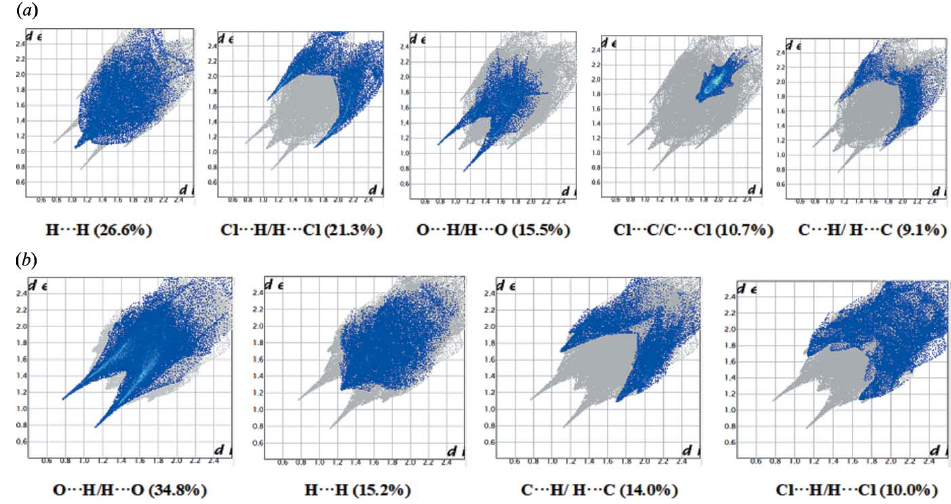
Figure 7 Two-dimensional fingerprint plots for ( a ) (I) and ( b ) (II). d i is the closest internal distance from a given point on the Hirshfeld surface and d e is the closest external contact.